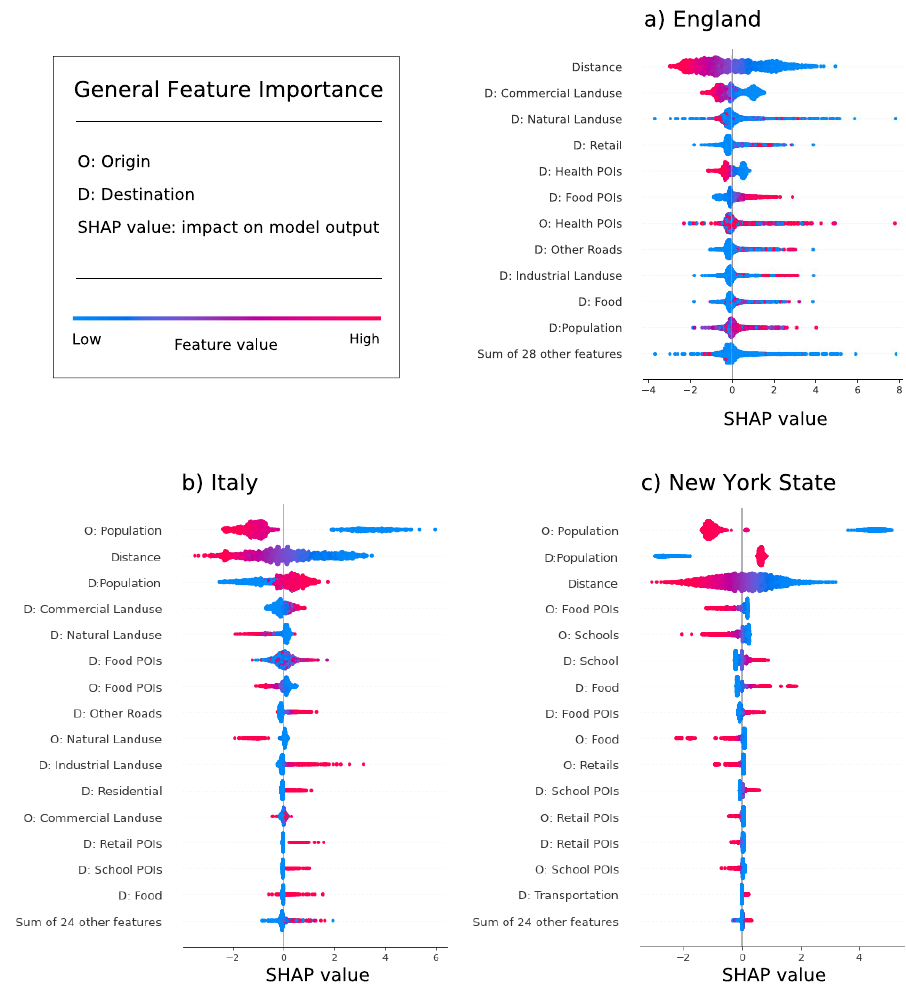
Fig. 5 Explaining Deep Gravity. Distribution of Shapely values for all features in Deep Gravity for England ( a ), Italy ( b ), and New York State ( c ). Features are reported on the vertical axis and are sorted from the most relevant on top to the least relevant on the bottom. Feature names starting with “ D: ” and “ O: ” indicate features of the destination and origin, respectively. Each point denotes an origin-destination pair, where blue points represent pairs where the feature has a low value and red points pairs with high values. For each variable, these points are randomly jittered along the vertical axis to make overlapping ones visible. The point ’ s position on the horizontal axis represents the feature ’ s Shapely value for that origin-destination pair, that is, whether the feature contributes to increase or decrease the fl ow probability for that pair. For example, high distances tend to be a travel deterrence while short distances are associated with an increment of